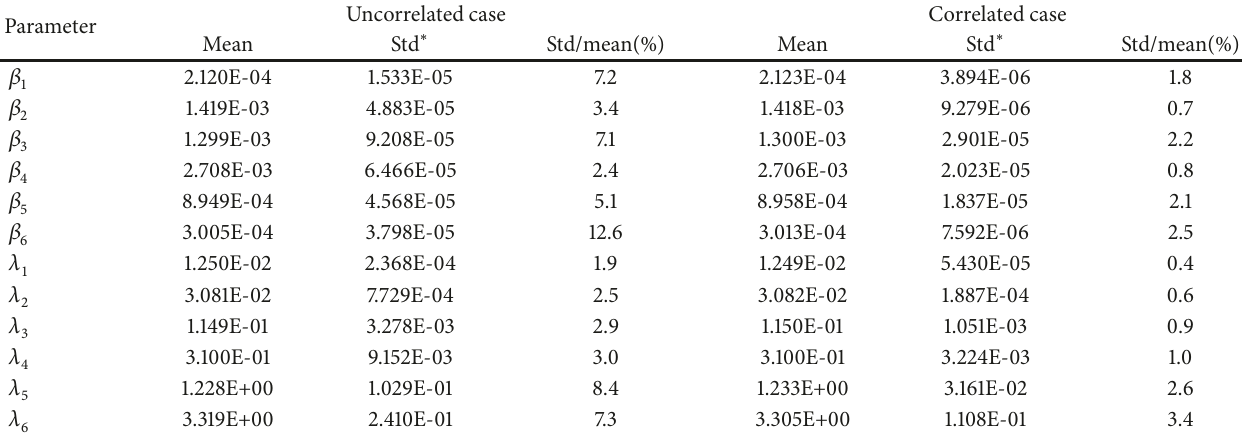
Table 5: Comparison of the kinetic parameters evaluation for a PWR pin-cell (BOL) when considering correlated U-235 thermal DND with the uncorrelated